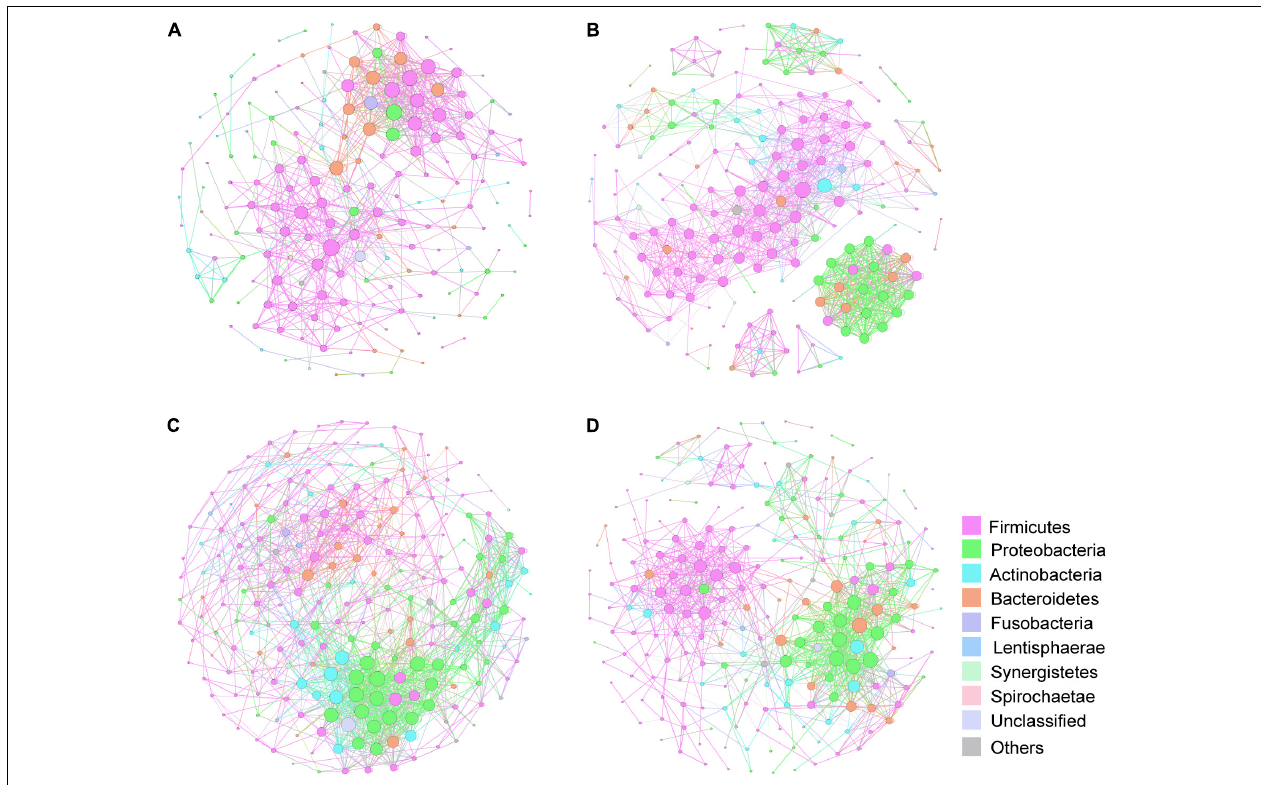
FIGURE 8 | Correlation network of the gut microbiome in the four groups. The correlation coefficient was calculated with Spearman rank correlation test (| ρ | ≥ 0.6). Gephi (v0.9) was used for network construction. (A) Correlation networks in HP. (B) Correlation networks in AAH/AIS. (C) Correlation networks in MIA. (D) Correlation networks in IA. Each circle represents the average relative abundance of a microbial species in that state. Node sizes are scaled according to their degrees of connections.